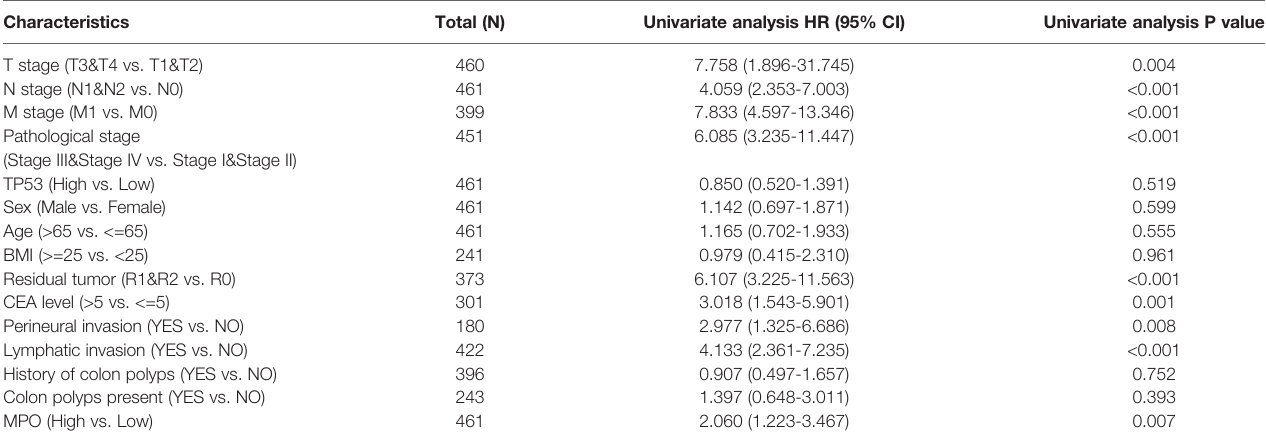
TABLE 4 | Univariate analysis of prognostic factors for DSS with the Cox regression model. Characteristics